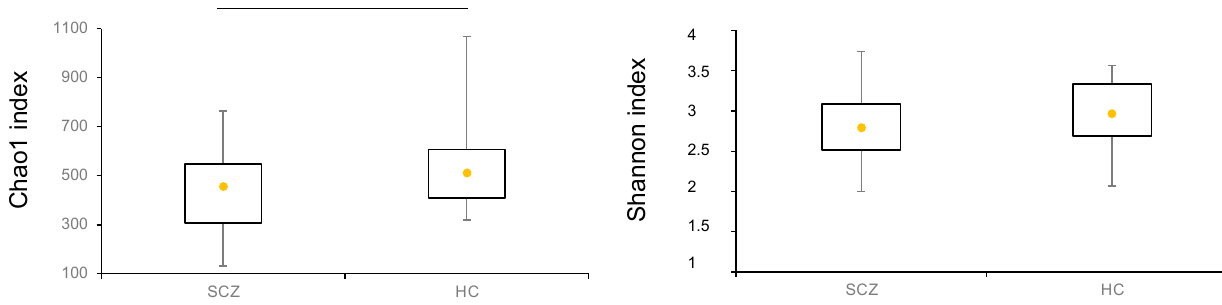
SCZ subject. Figure 4 represents the distribution of centroid z-scores computed by PE- fied bacterial patterns at each taxonomic level considered.